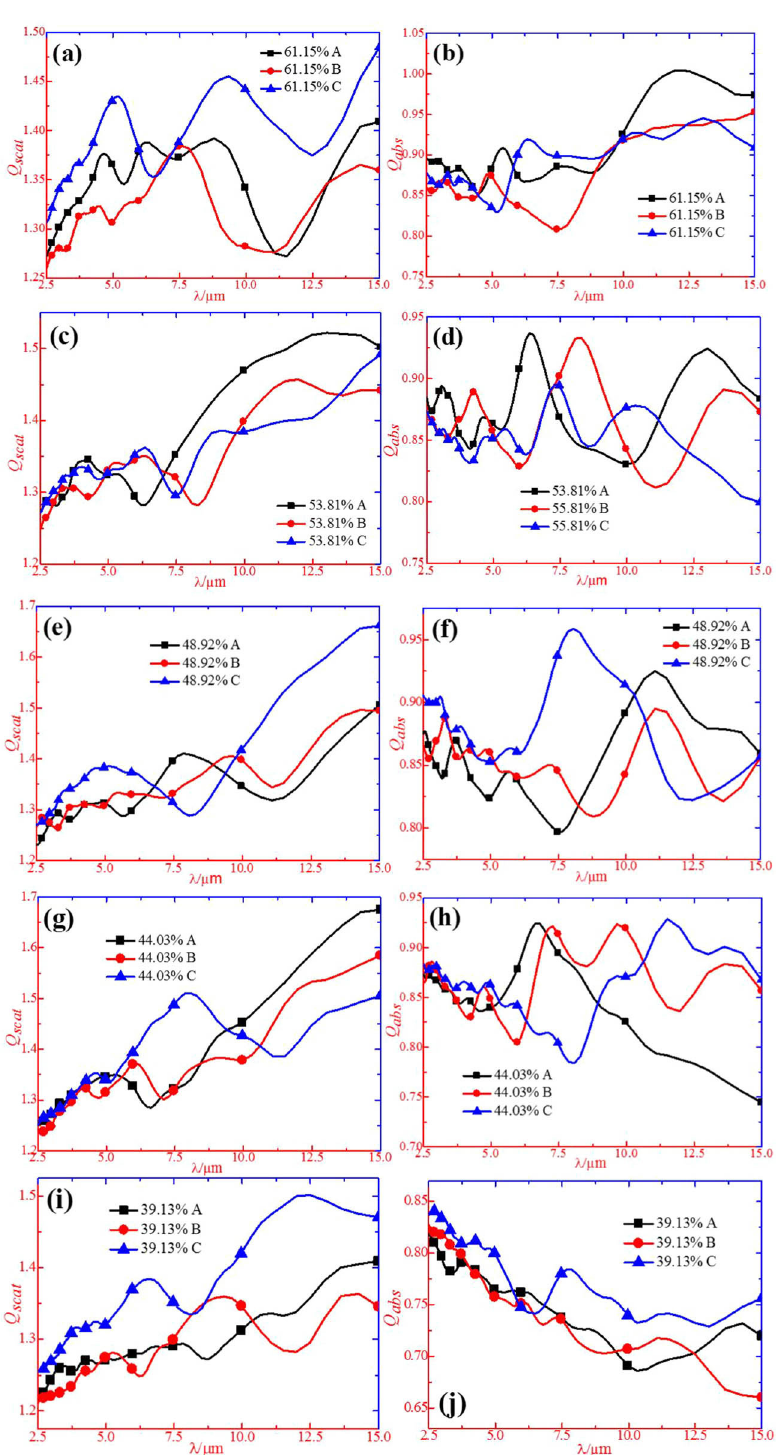
Figure 6: Scattering and absorption factors of carbon nano fi bers with 2D random arrangements as a function of wavelength: ( a ) and ( b ) at a content of 61.15%, ( c ) and ( d ) at a content of 53.81%, ( e ) and ( f ) at a content of 48.92%, ( g ) and ( h ) at a content of 44.03% and ( i ) and ( j ) at a content of